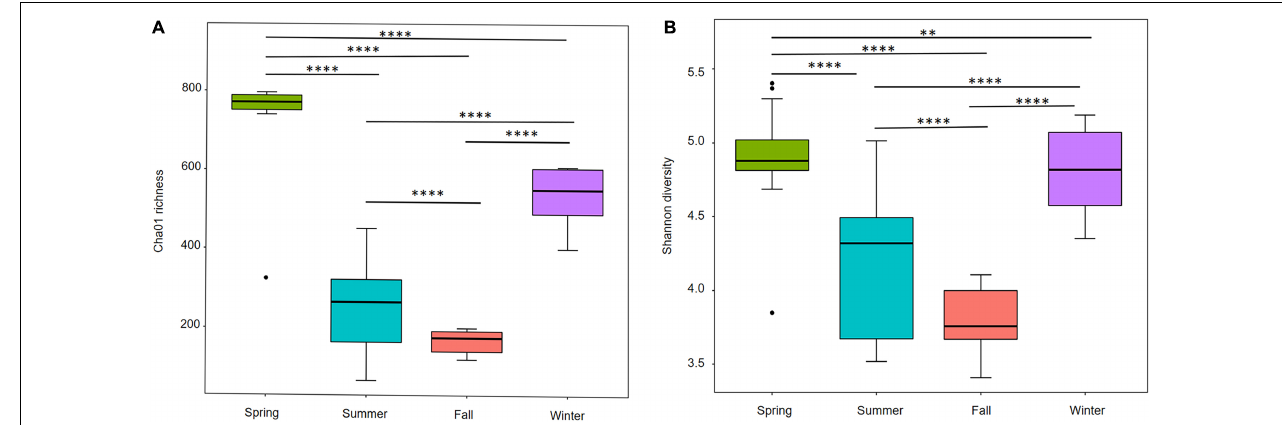
FIGURE 2 | The Alpha diversity index of the Yellow River Delta benthic diatoms communities at different sampling seasons. (A) Chao1 richness. (B) Shannon diversity. ** indicates that p < 0.01, **** indicates that p < 0.0001.